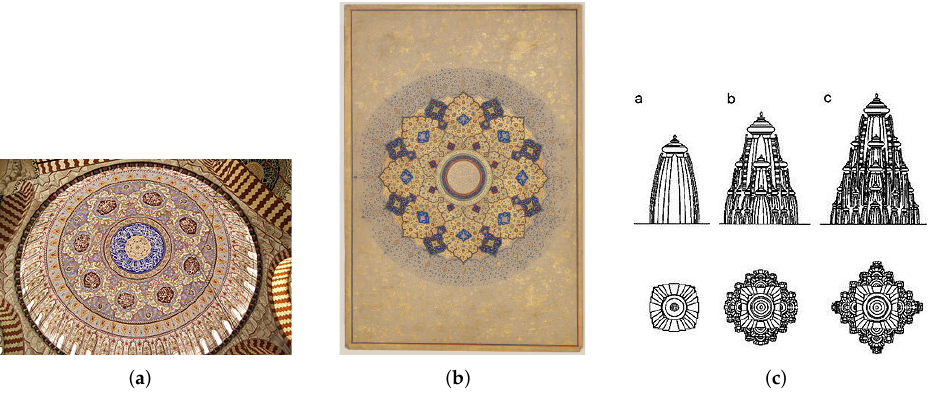
Figure 15. Some fractal designs of ancient times. Image source: Wikipedia. ( a ) Main dome of Selimiye Mosque (Edirne, Turkey), ( b ) Hand painted rugs, and ( c ) Temple Design, available at https://en.wikipedia.org/wiki/Fractal_art (accessed on 20 October